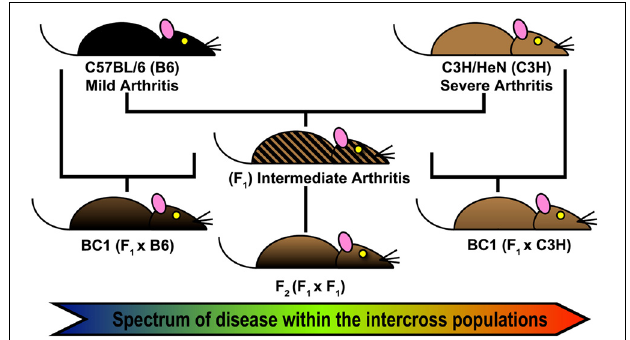
FIGURE 1 | Forward Genetics approach for Lyme arthritis severity. Intercross populations of B6 and C3H mice were used for identification of Quantitative Trait Loci (QTL) regulating Borrelia burgdorferi associated arthritis and other responses related to infection ( Bbaa ). Arthritis and other metrics of host response were assessed at 4 weeks of infection. A total genome scan was performed for each infected mouse ( n = 450) and threshold permutation analysis identified loci associated with disease and